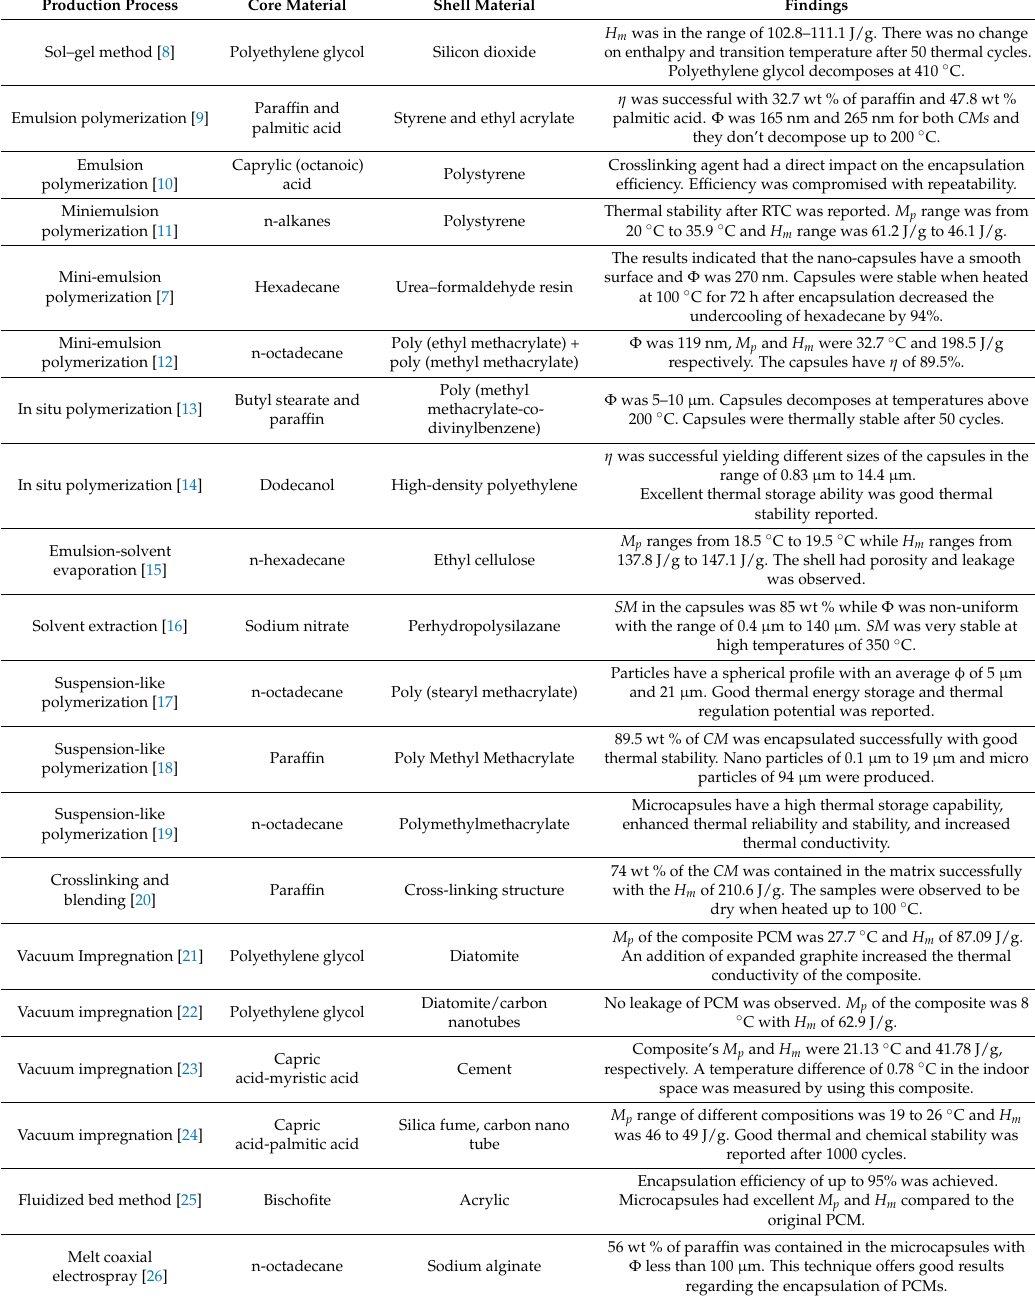
Table 1. Summary of findings of experimental research on PCM encapsulation using different core and shell materials, production processes, and reported